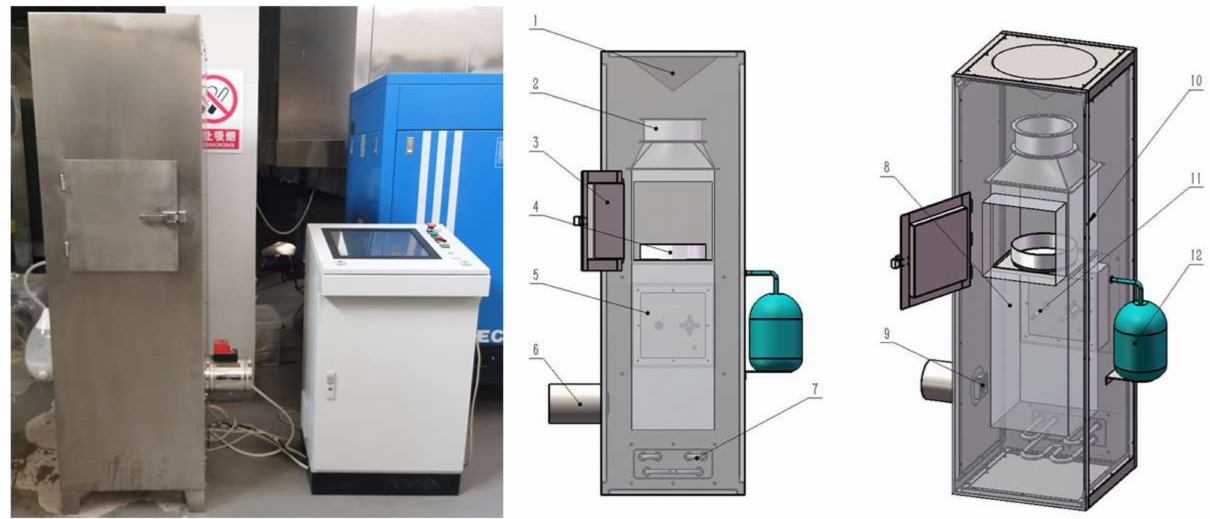
Figure 3. Multi-parameter-controllable drying test device: 1. wind shunt, 2. axial flow fan, 3. material bin door, 4. material sieve, 5. sensor bin, 6. electric sealing valve, 7. heating pipe, 8. inner tank, 9. wet exhaust fan, 10. test-bed shell, 11. sensor group, and 12.